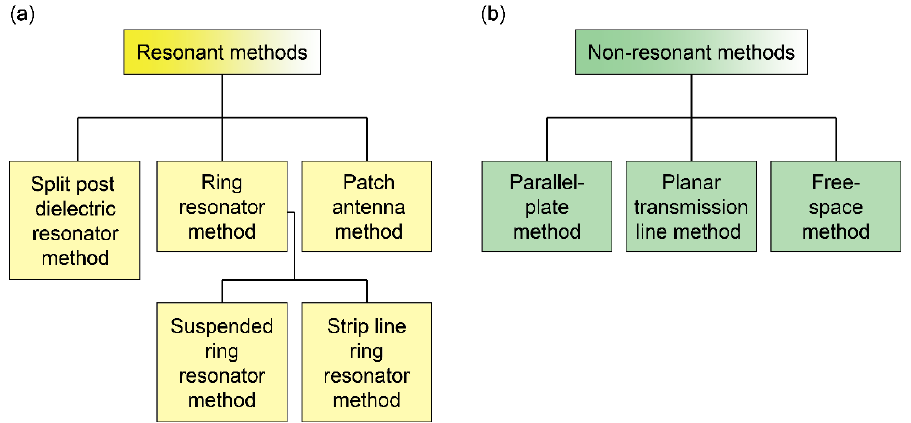
Figure 9. ( a ) Resonant and ( b ) non-resonant methods commonly used for dielectric characterization of textile